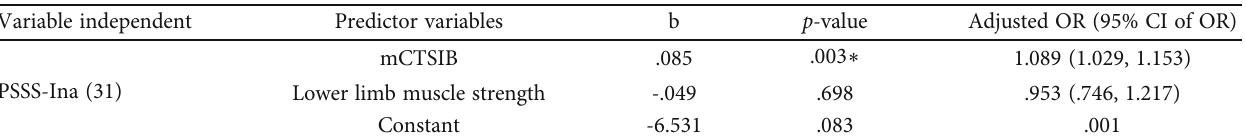
Table 5: The fi nal model of multiple logistic regression of PSSS-Ina used cut of 31 as severe restriction in T2DM with vertigo complaint and positive VD tests ( n = 55 ).